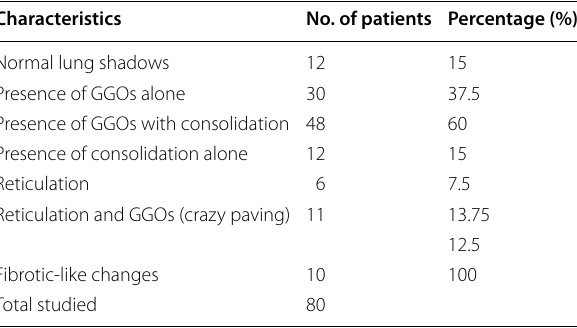
Multiple patients had multiple lung findings